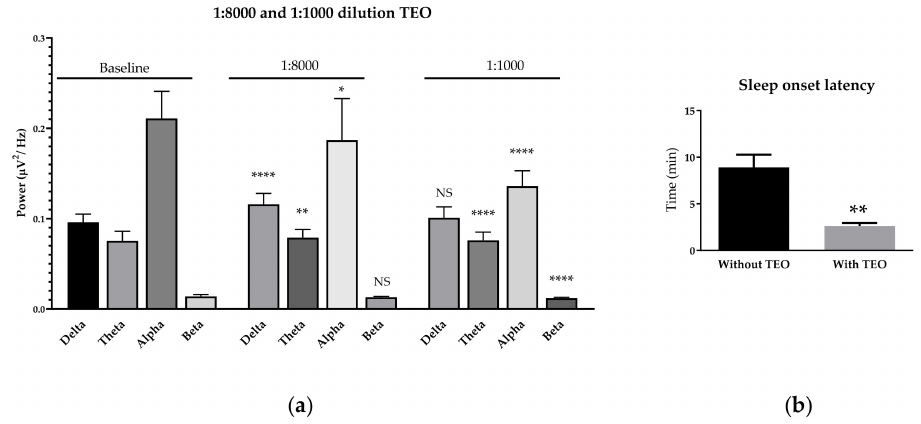
Figure 8. E ff ects of 1:8000 and 1:1000 oil dilution on brain waves ( a ). Sleep onset latency observed in female subjects ( b ). p value: ns ≥ 0.05, * < 0.05, ** < 0.01, **** <